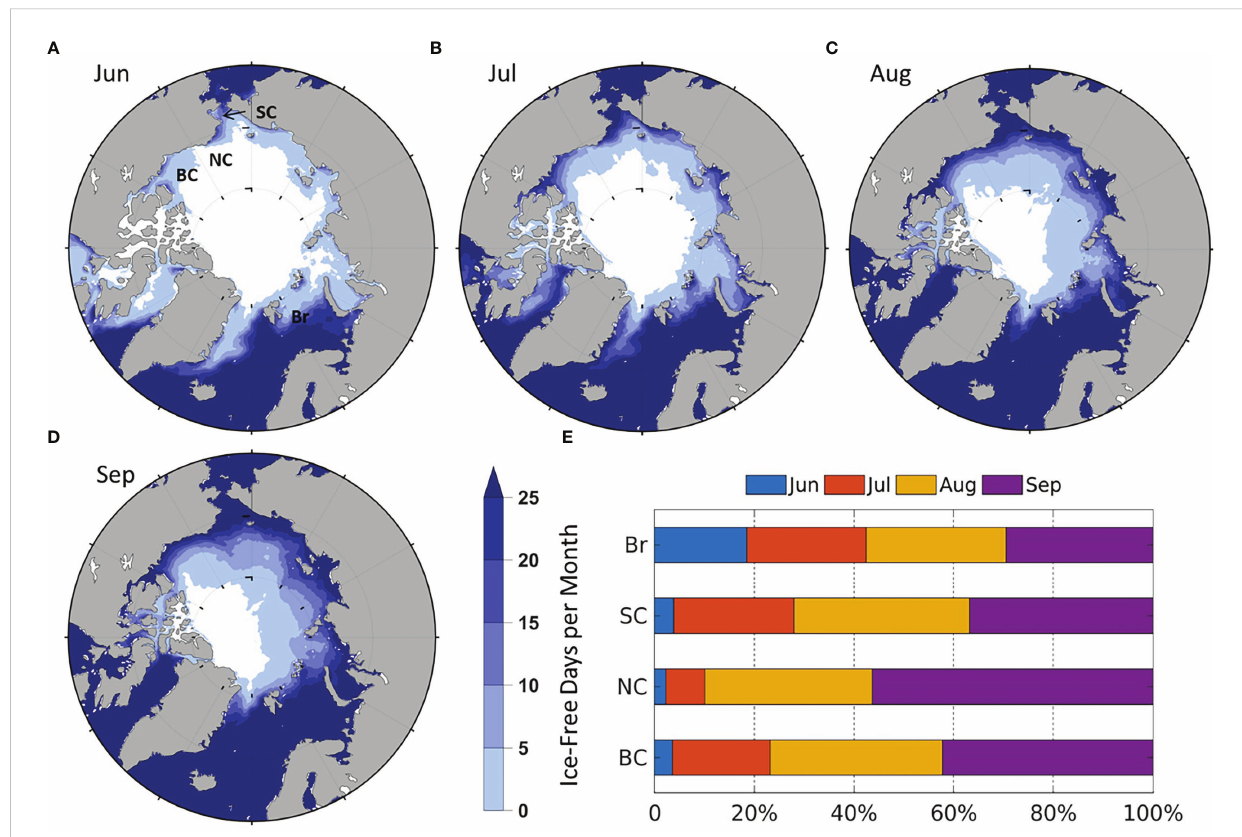
FIGURE 3 Modeled average number of ice-free days (1990-2014) in (A) June; (B) July; (C) August; (D) September. The average of zero days is colored white; (E) Average percentage of monthly contribution to summer IFR by